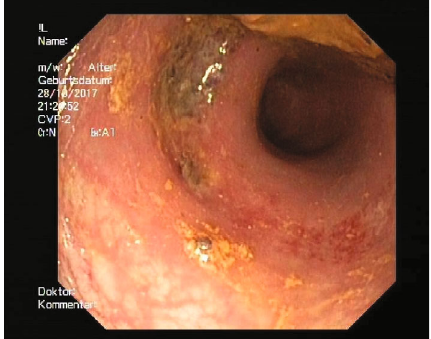
Figure 4: Hematoma in